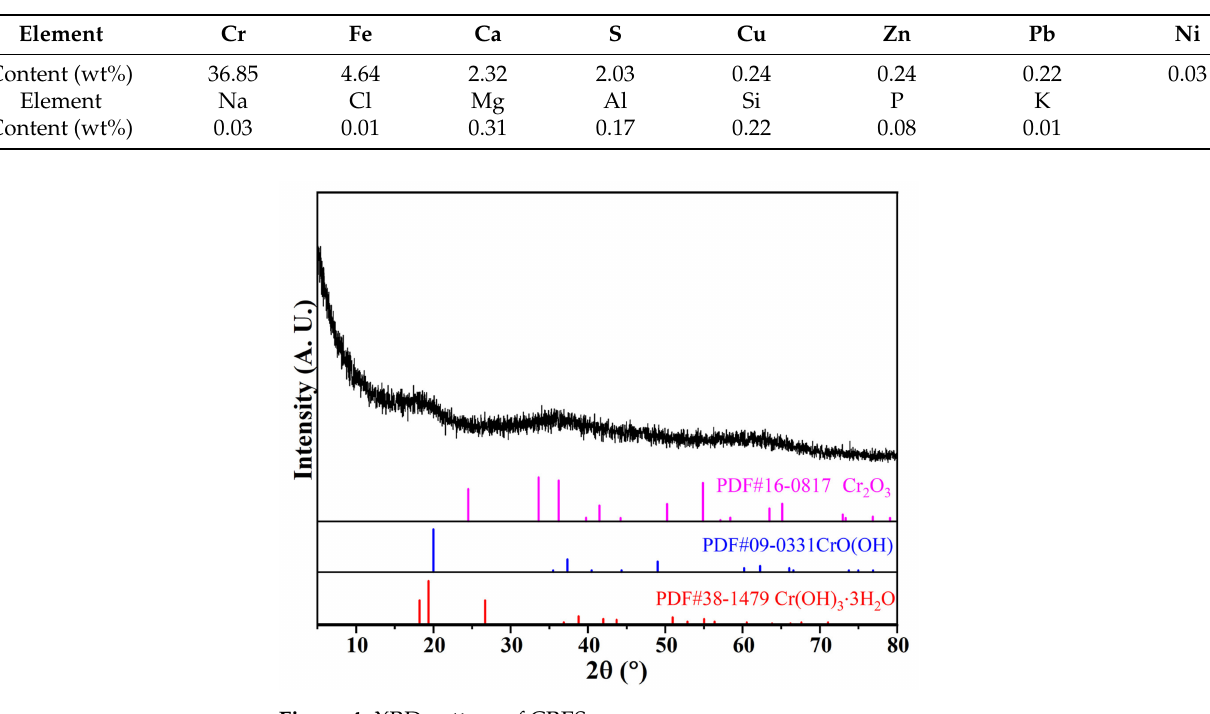
Table 2. Chemical composition of CRES.